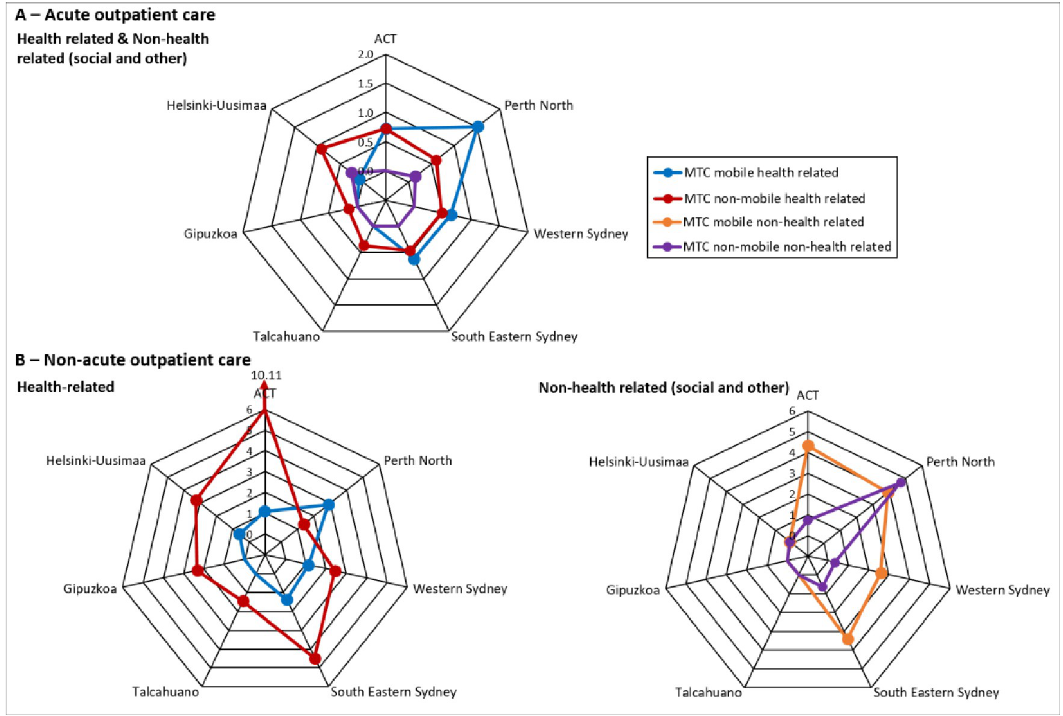
Fig 4. Availability of outpatient care per 100,000 adults: Australian and international comparison. The axes of these graphs represent each of the study regions. Coloured lines representing the different types of outpatient care join the points on each axis indicating the rate of that type of care per 100,000 adults for that region.